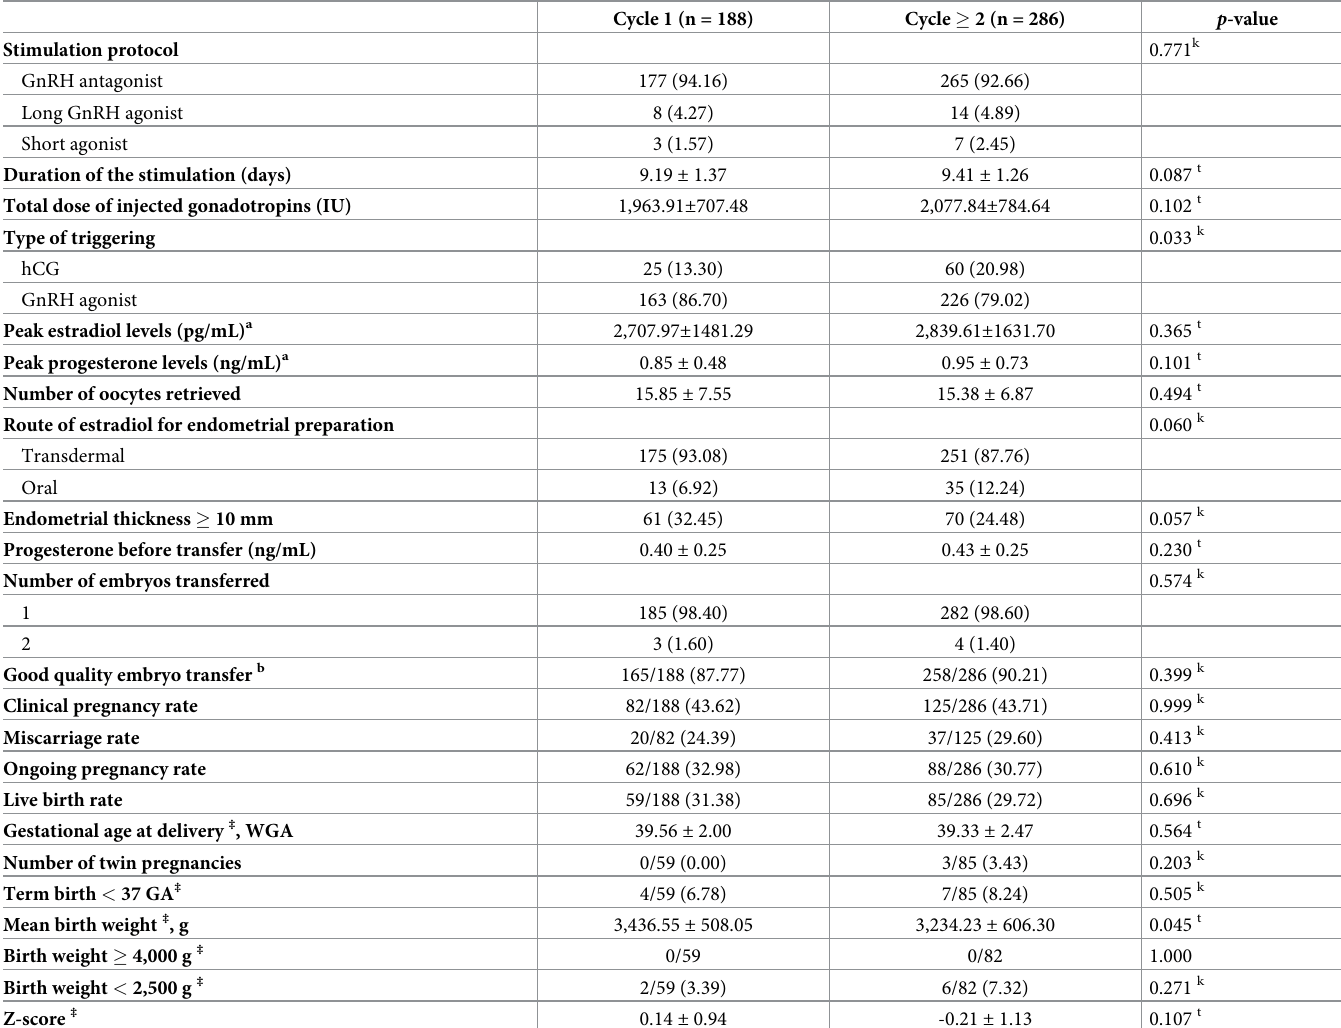
Table 2. ART characteristics and